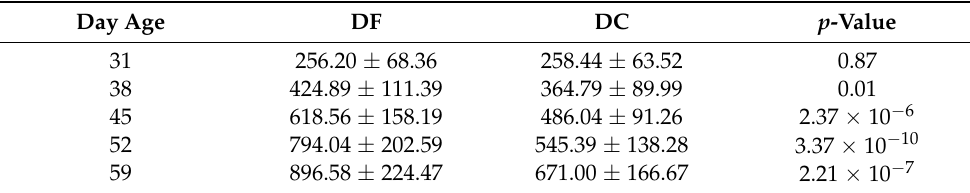
Table 2. Effects of conventional system of free range and grape-duck system on duck body weight (unit: g).